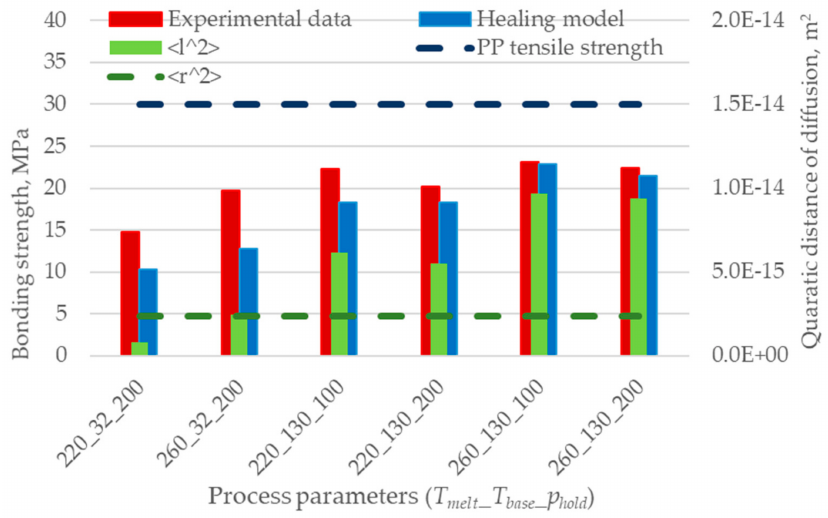
Figure 12. Gradient of the quadratic distance of di ff usion for specimens produced with di ff erent interface temperature evolutions.